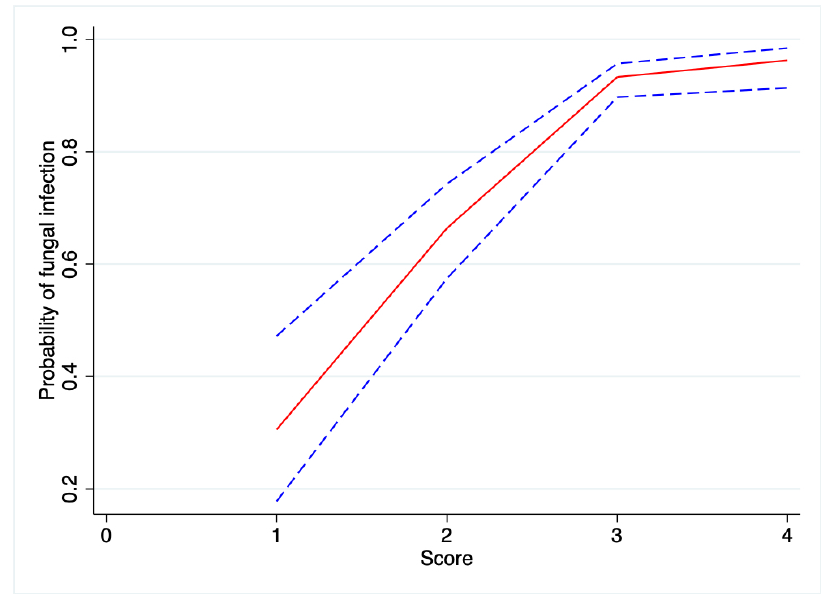
Figure 2. Operating characteristic curve showing the probability of fungal infection at different scores (95% CI dashed lines).